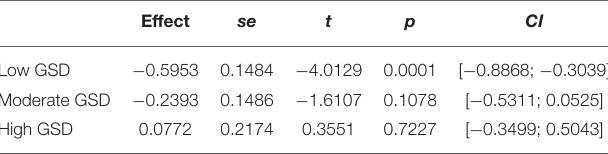
TABLE 4 | Conditional effects of GSA on SBQ-R among those with relatively low (2.1667), moderate (3.6667), and high (5.0000)